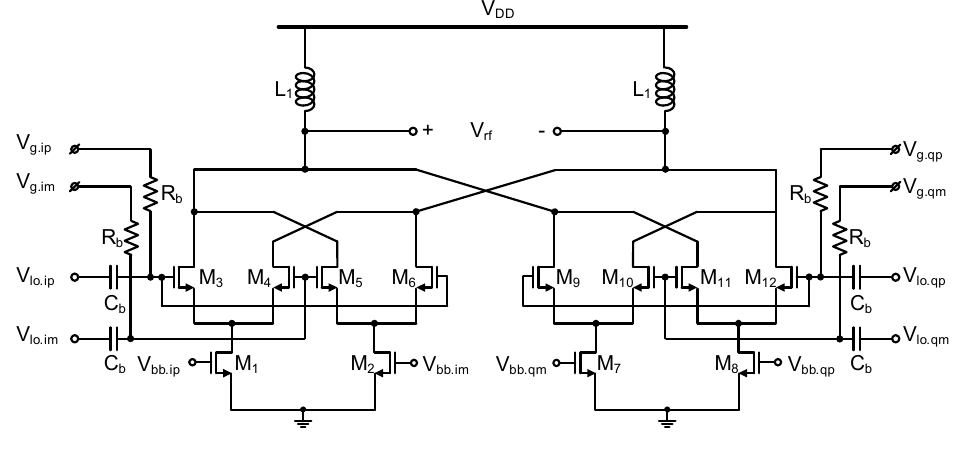
Figure 3. Quadrature mixer schematic.